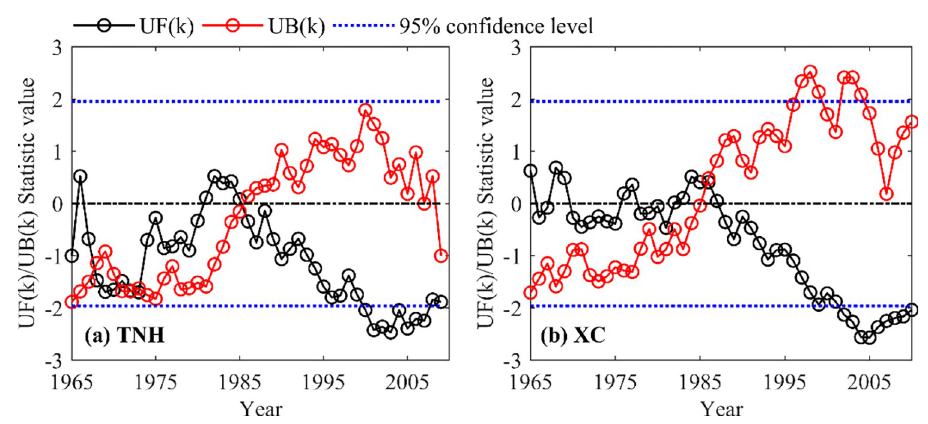
Fig 3. Mutations in runoff sequence at TNH and XC hydrological stations from 1965 to